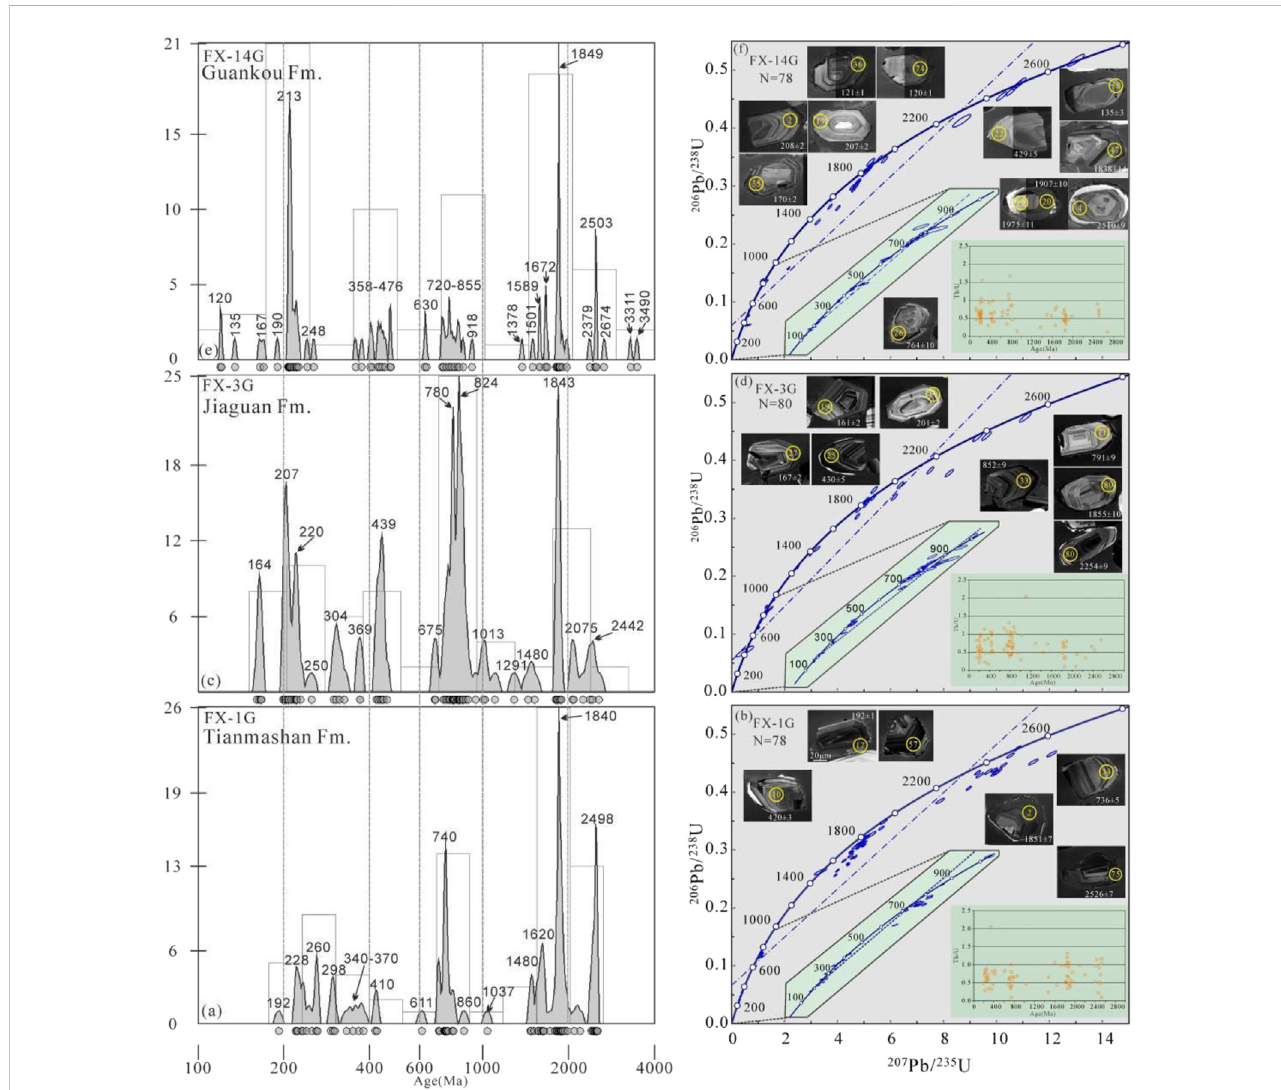
FIGURE 10 Cathodoluminescence images of the selected zircon grains and zircon U-Pb concordia and kernel density estimation (KDE) of samples of the Tianmashan Formation (A, B) , Jiaguan Formation (C, D) , and Guankou Formation (E, F) .